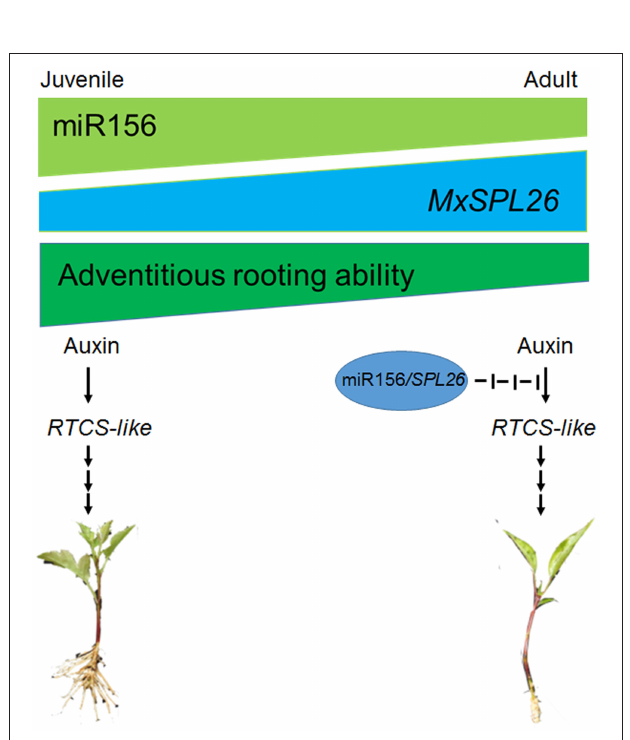
FIGURE 12 | Illustration of role of juvenility and auxin in triggering adventitious rooting. In adult leafy cuttings, decline of miR156 caused high expression level of SPL26. This modules may inhibit transcript abundances of RTCS -like gene induced by auxin, thereby reducing the adventitious rooting capacity in adult